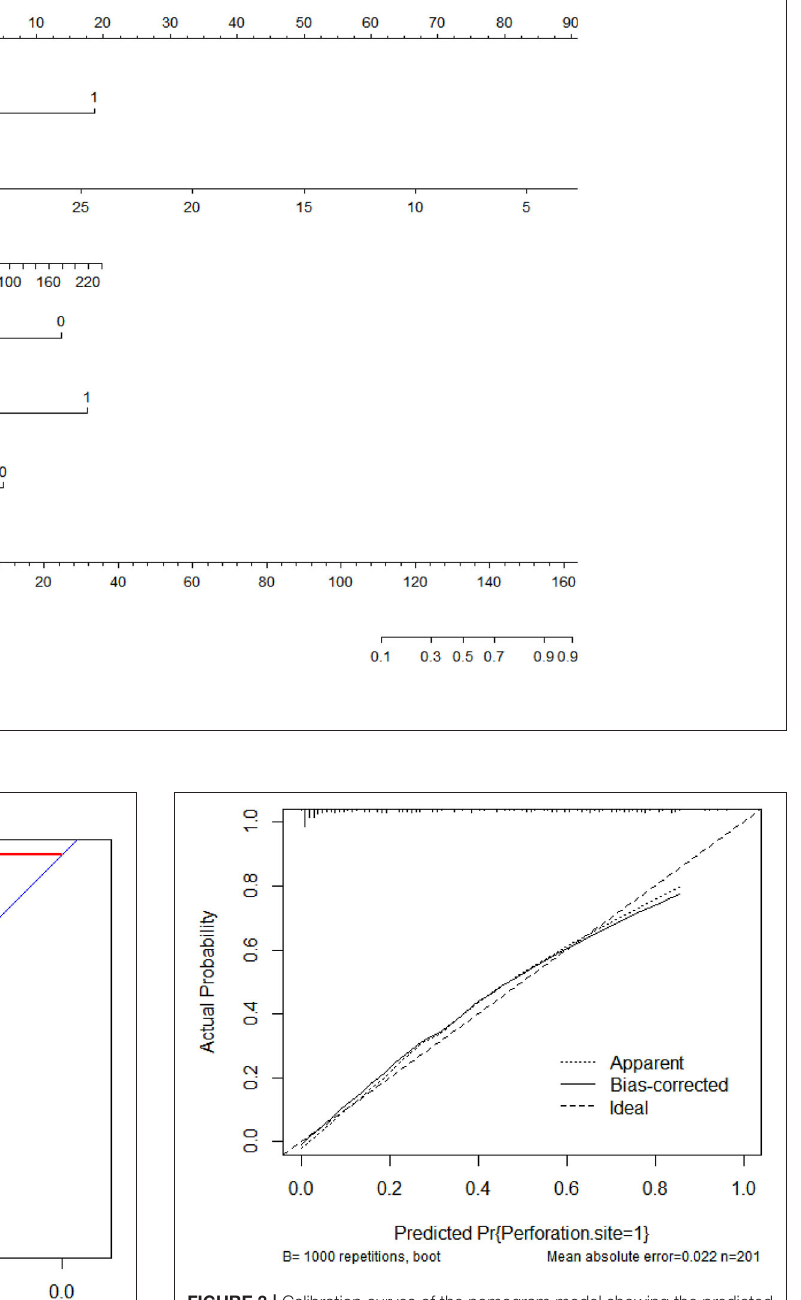
nomogram was 0.876 (95% CI: 0.804–0 · 890) for the ( Figure 2 ). The calibration curve for the model showed